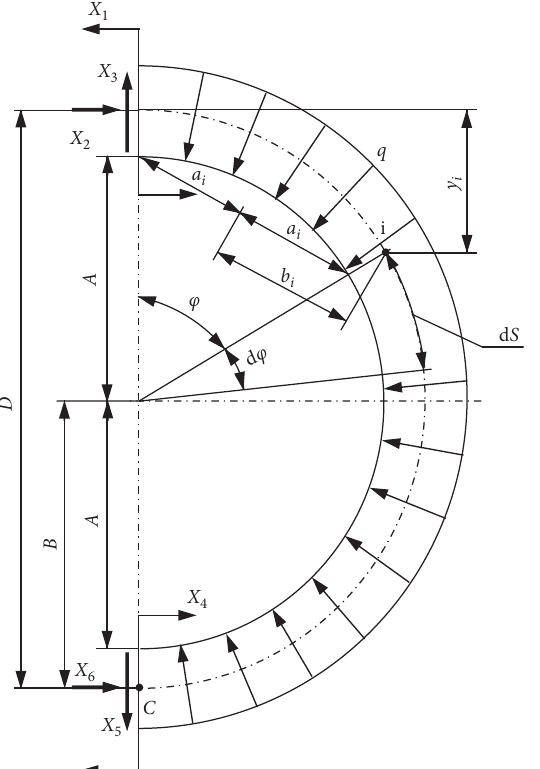
Figure 2: Calculation scheme of the ring with a radial load acting on its circuit.